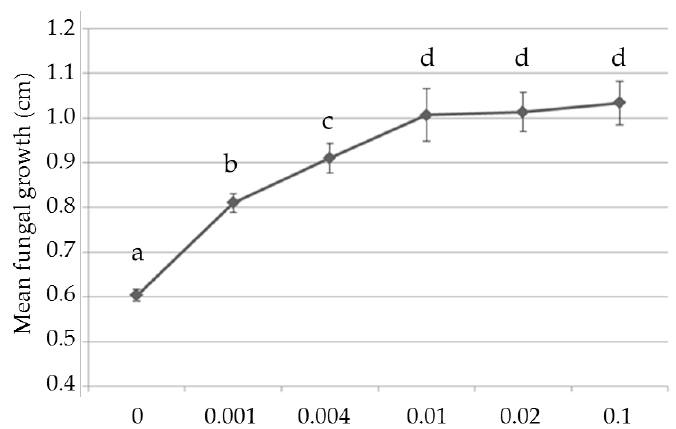
Figure 2. Biocidal effect of surfactin on the in vitro fungal growth of Zymoseptoria tritici . Potato dextrose agar (PDA) medium was amended with five decreasing concentrations of surfactin: 0.1 mg mL −1 , 0.02 mg mL −1 , 0.01 mg mL −1 , 0.004 mg mL −1 , and 0.001 mg mL −1 . The control corresponds to PDA medium without surfactin (0 mg mL −1 ). Means tagged with the same letters are not significantly different using the Tukey test at p = 0.05.